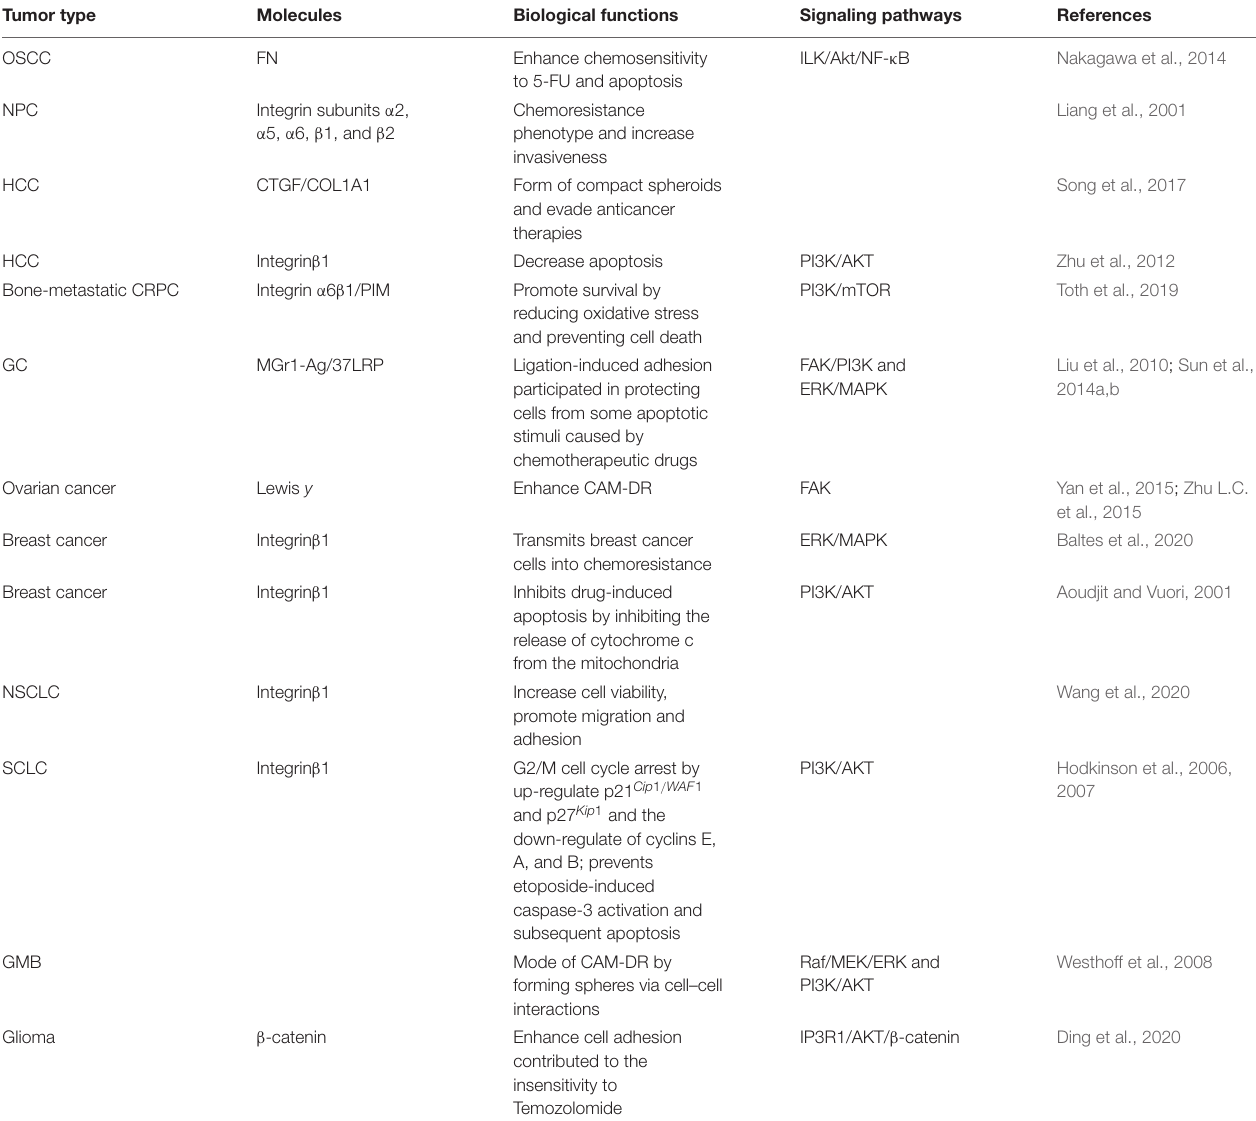
TABLE 3 | Roles and mechanisms of CAM-DR in solid